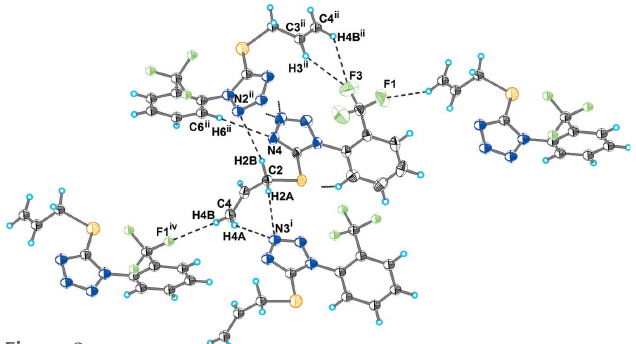
Figure 2 The hydrogen-bonding of molecules in (I). Hydrogen bonds are shown as dashed lines. The symmetry codes are as in Table 1.